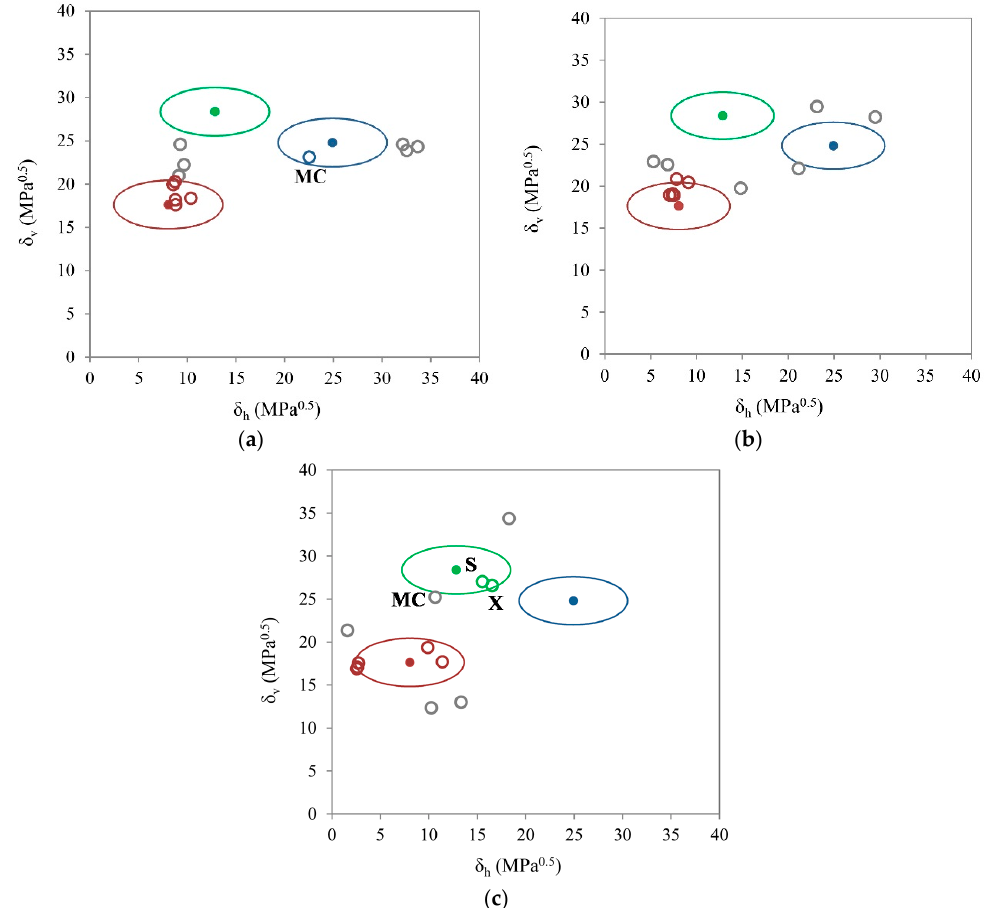
Figure 5. Bagley’s plot; values of solubility parameters of polymers and excipients according to ( a ) Hoftyzer and Van Krevelen; ( b ) Stefanis and Panayiotou and ( c ) Just and Breitkreutz; polymers and excipients are marked as grey circles, while ibuprofen is presented as a red ellipse, ibuprofen lysinate, whose values of solubility parameters were obtained using EHA, is presented as a green ellipse and ibuprofen lysinate, whose values of solubility parameters were obtained by using the IGC method, is presented as a blue ellipse. MC—methylcellulose; S—sucrose; X—xylitol. As it can be seen in Figure 5, the positions of the ibuprofen lysinate ellipses are different due to the differences in the values of the solubility parameters. In the case of the blue ellipse, when using the method authored by Hoftyzer and Van Krevelen, methylcellulose appears in the solubility area (Figure 5a). In the immediate vicinity of the blue ellipse, when using method authored by Stefanis and Panayiotou, xylitol also appears. In the case of the green ellipse of ibuprofen lysinate, when using method of Just and Breitkreutz a distance ≤ 5.6 MPa 0.5 is calculated only for xylitol, sucrose and methylcellulose (Figure 5c).